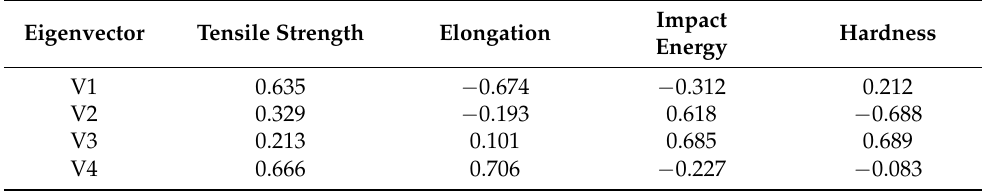
Table 7 . Results of verification test for multiobjective optimization. Table 5. Eigenvectors for multiobjective optimization.